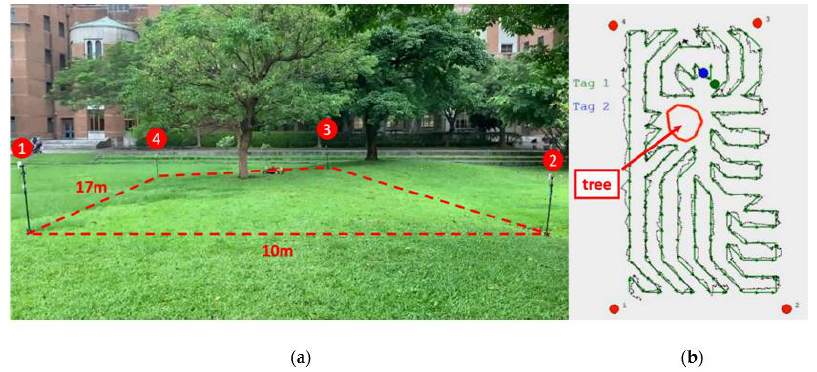
Figure 15. Autonomous mower scenario. ( a ) The lawn mowing area of 10 × 17 m 2 with a tree inside. ( b ) Planned path and the actual trace of the auto mower.